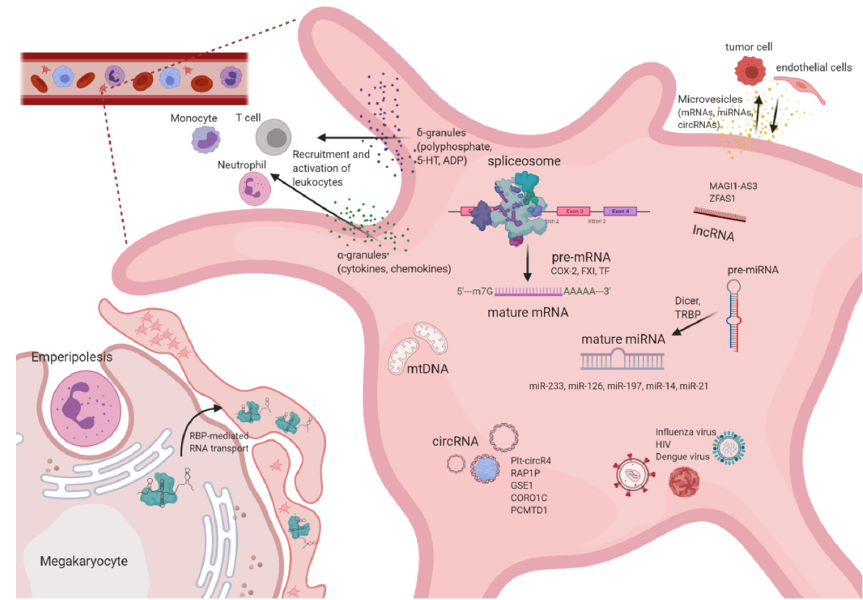
Figure 1. Nucleic acids landscape of platelets. Platelets harbor a diverse set of RNA species, most of which are inherited from megakaryocytes. Additionally, communications with surrounding cells